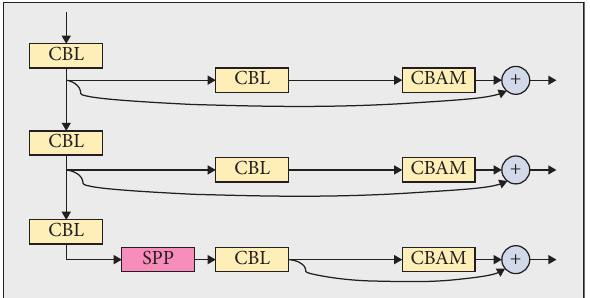
Figure 6: Schematic diagram of the AtFPN module